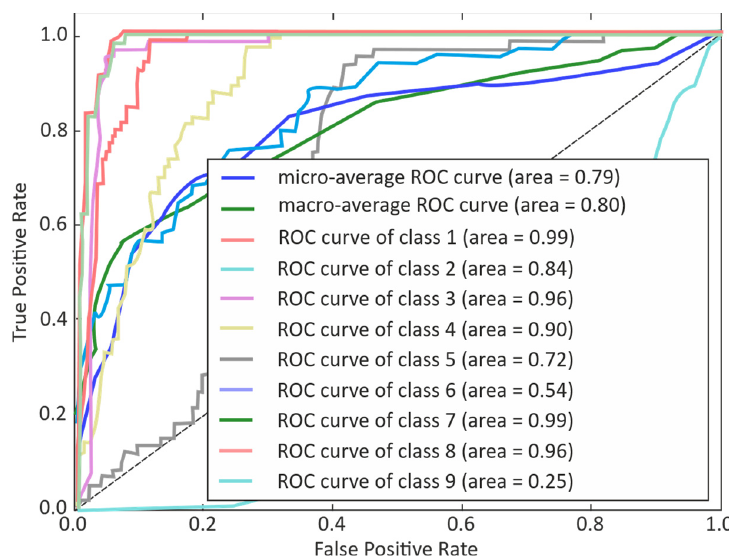
Figure 6. ROC plot for Gaussian NB classifier (micro-averaged 98%).